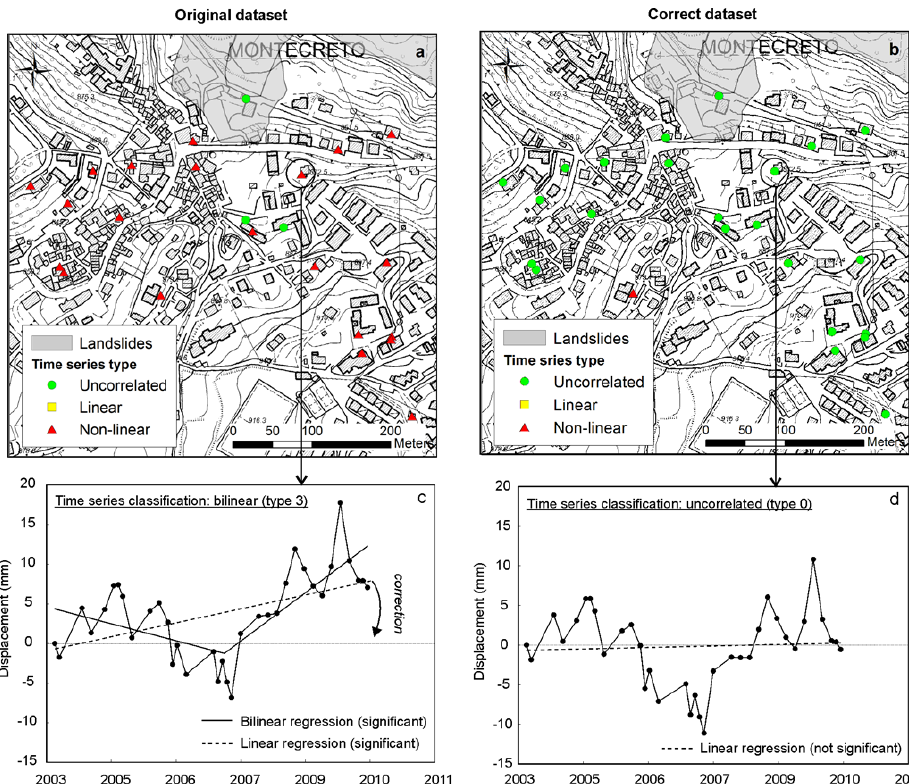
Fig. 15. Comparison of time series classification in the area of Montecreto (Modena province, northern Apennines of Italy) obtained by the original (a) and corrected (b) dataset. The charts (c) and (d) show the time series classification of a representative point in the